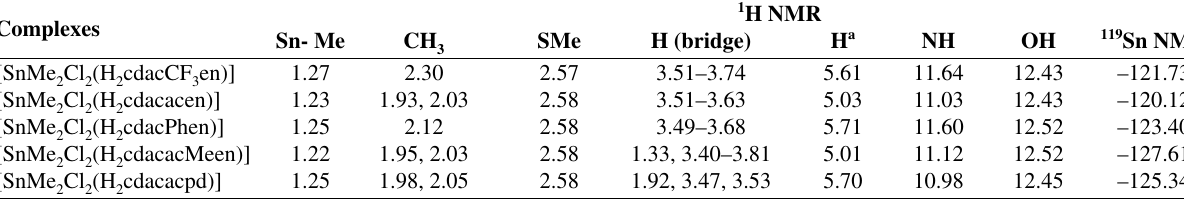
Table 2. 1 H and 119 Sn NMR spectral data of the prepared complexes ( δ /ppm) Complexes